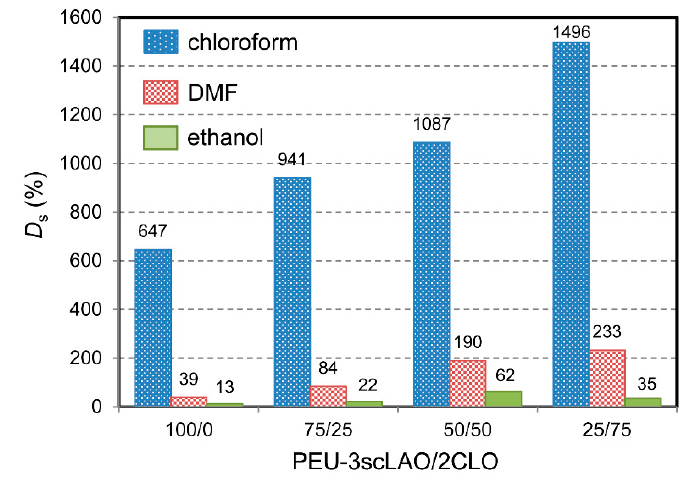
Figure 3. Degree of swelling for PEU-3scLAO/2CLOs (100/0, 75/25, 50/50, 25/75 and 0/100) in chloroform, DMF or ethanol.